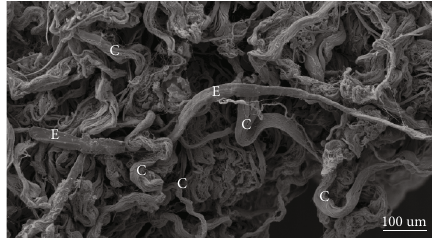
Figure 3: Photoaging of the skin. Representative photomicrograph of scanning electron microscopy (SEM): presence of a net of collagen fi bers grouped in a disordered form (c) permeated by a large elastic mature fi ber (E).